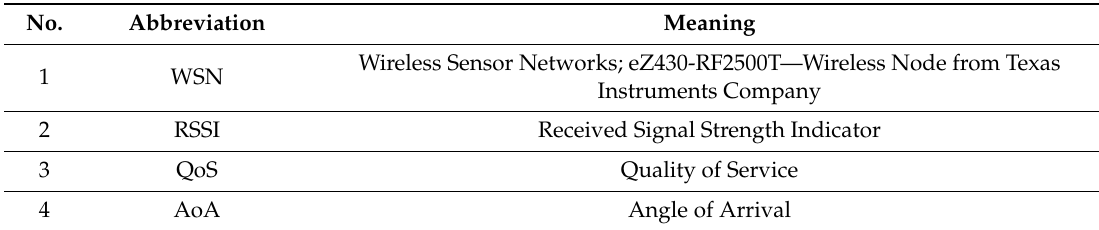
Table 1. Notations and